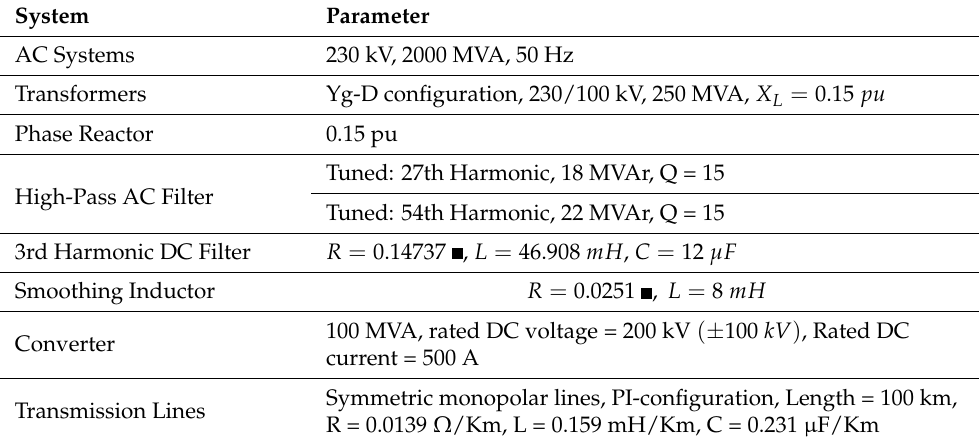
Table 1. AC System and Converter